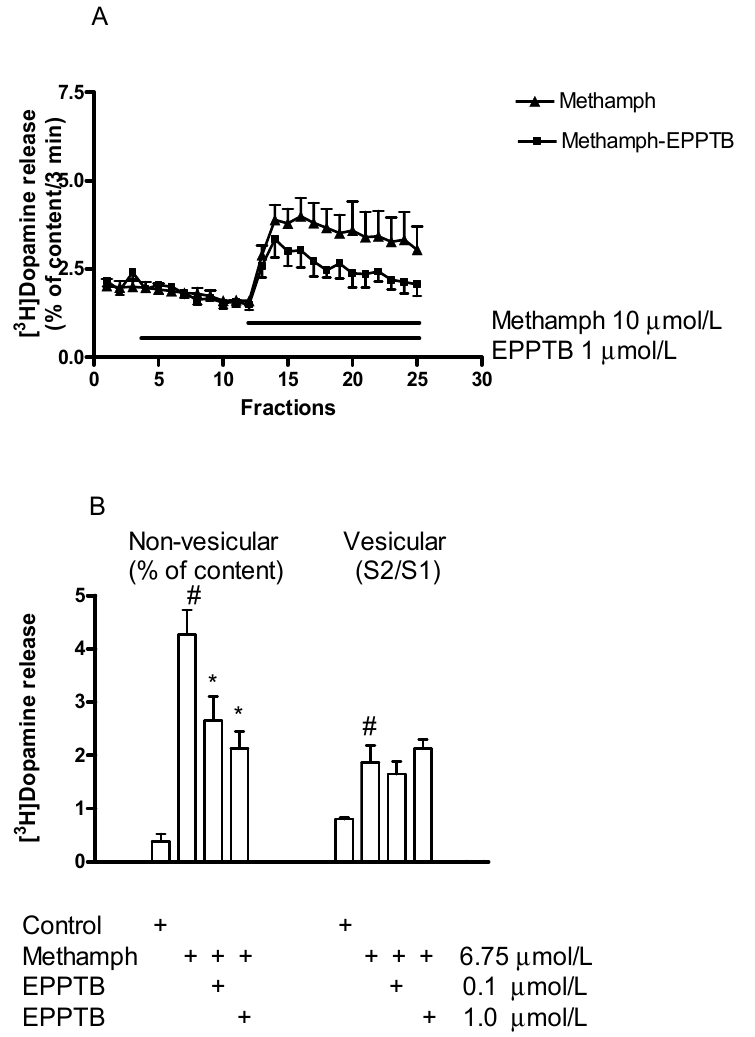
± )methamphetamine (methamph)-induced Figure 11. ( A ) EPPTB decreased the (±)methamphetamine (methamph)-induced non-vesicular Figure 11. ( A ) EPPTB decreased the (